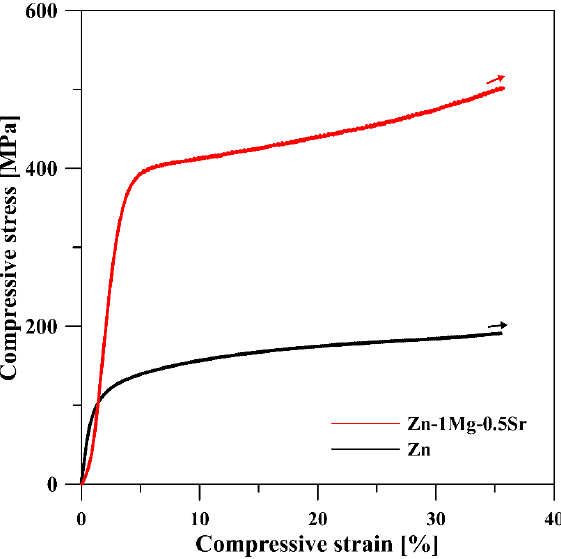
Figure 9. Compressive stress – strain curves of Zn – 1Mg – 0.5Sr alloy and Zn prepared by SPS